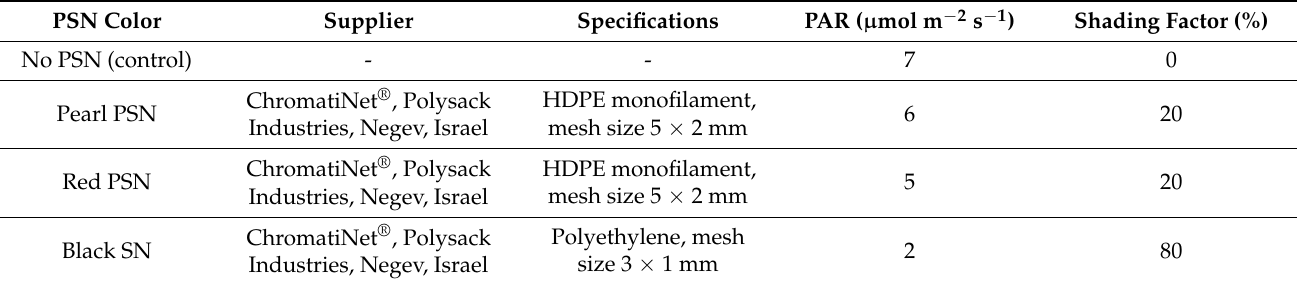
Table 1. Light intensity was measured as the photosynthetic active radiation (PAR) and shading factor provided by the photo-selective and black standard nets (PSN and SN, respectively) used in the